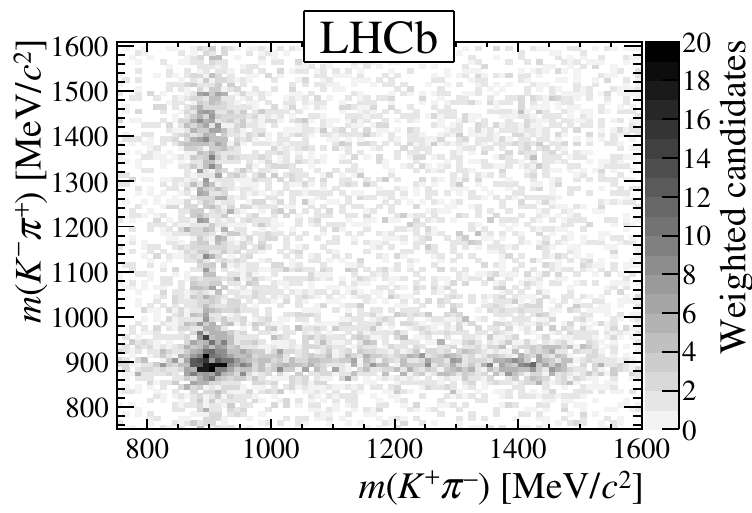
Figure 4 . Distribution of the two ( K(cid:25) ) pair invariant masses, with the signal weights applied, after all of the selection